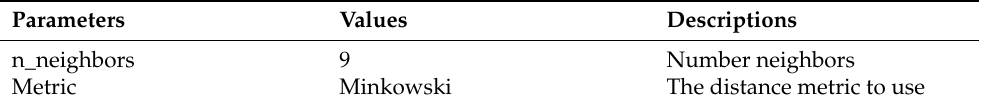
Table 5. Optimized KNN